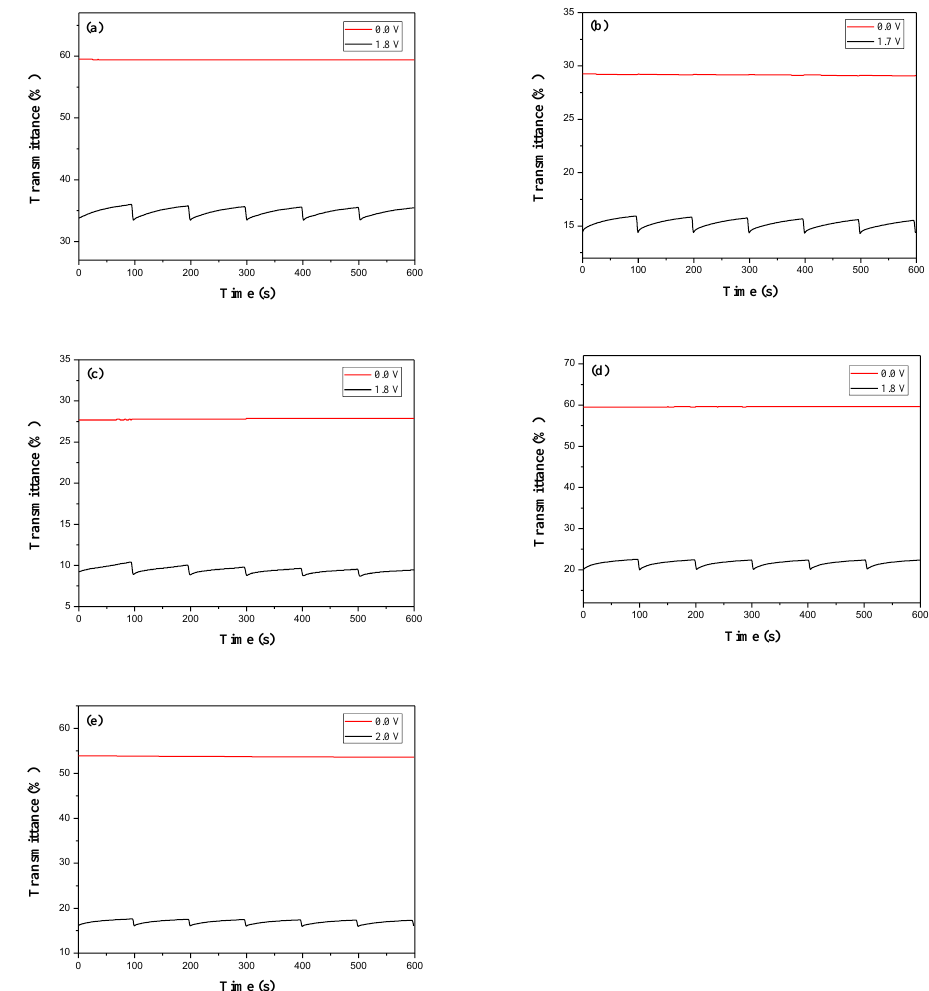
Figure 9. Open circuit stability of ( a ) PDiCP/PEDOT-PSS; ( b ) P(DiCP- co -CPDT)/PEDOT-PSS; ( c ) P(DiCP- co -CPDT2)/PEDOT-PSS; ( d ) P(DiCP- co -CPDTK)/PEDOT-PSS; and ( e ) P(DiCP- co -CPDTK2)/PEDOT-PSS devices.